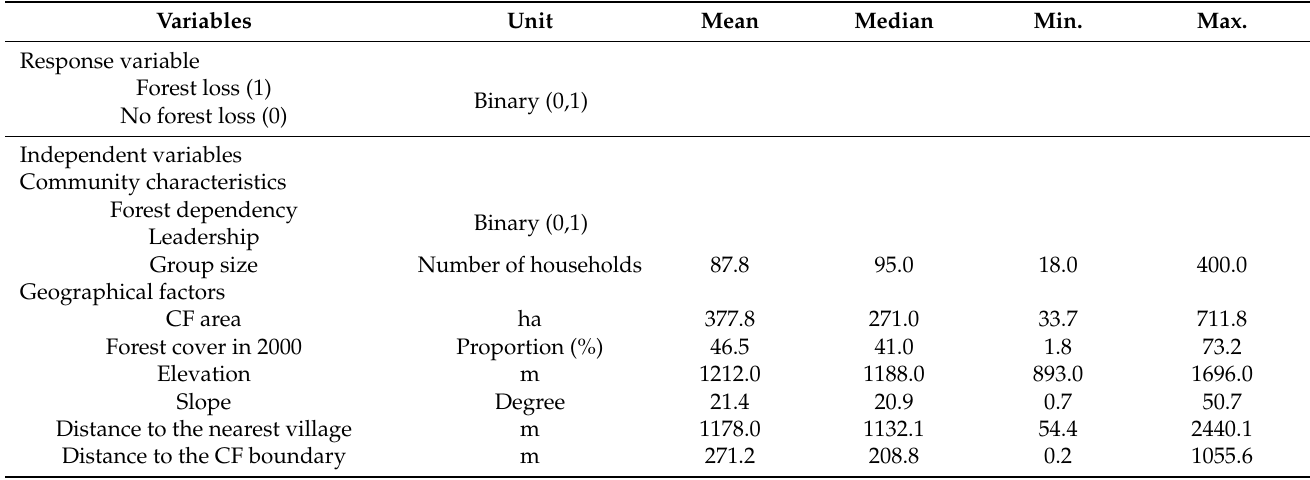
Table 1. Summary statistics for the response and independent variables used in the GLMM model.